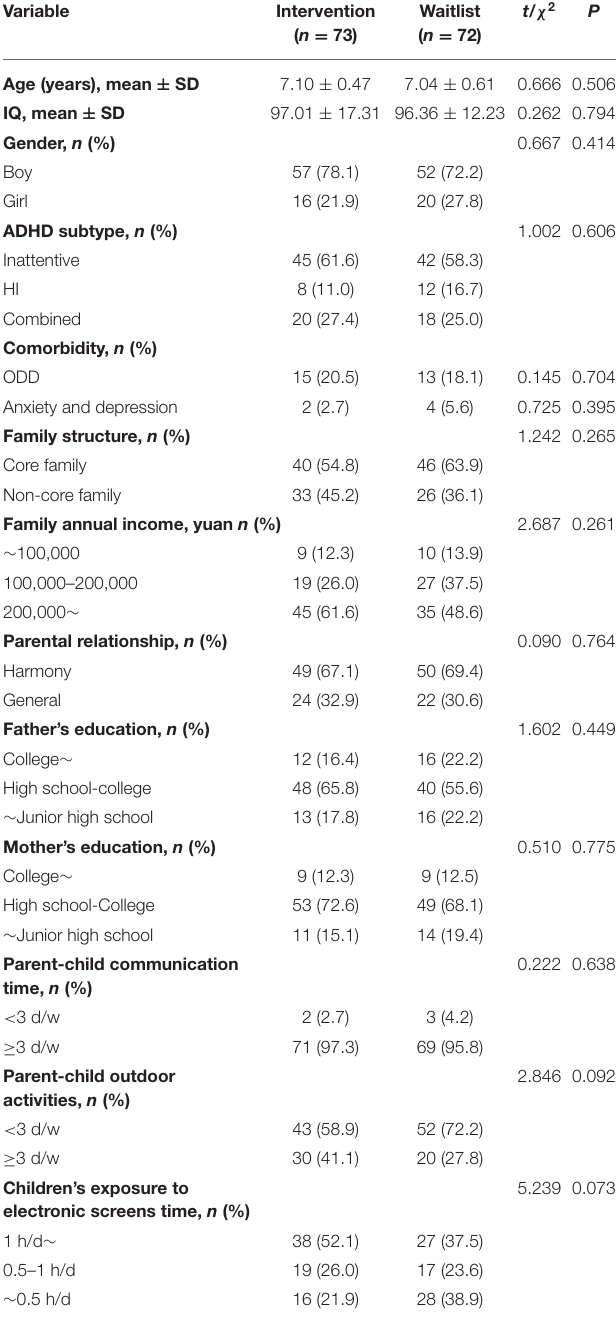
TABLE 2 | Demographic characteristics of the intervention group and the waitlist group. Variable